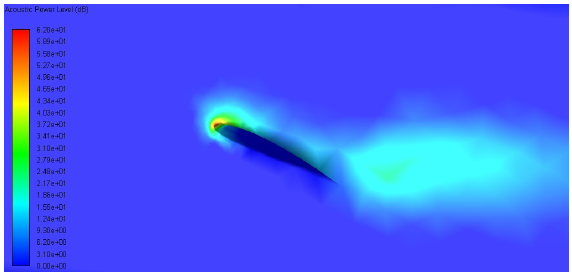
Figure 3. Deflected Airfoil vane, noise generation (10 m/s)